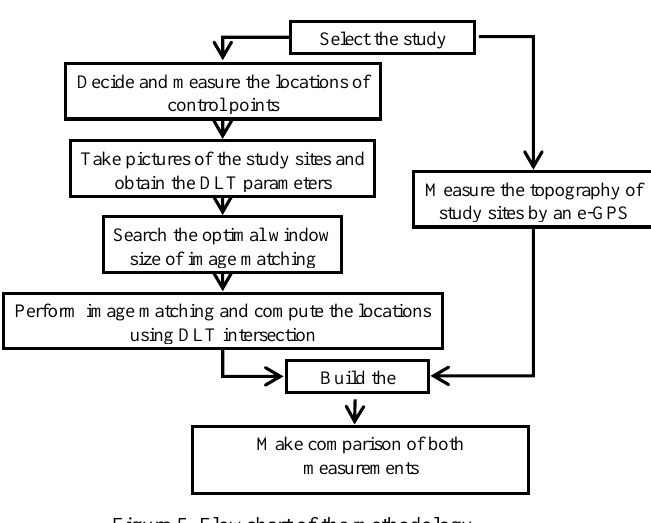
Figure 5. Flowchart of the